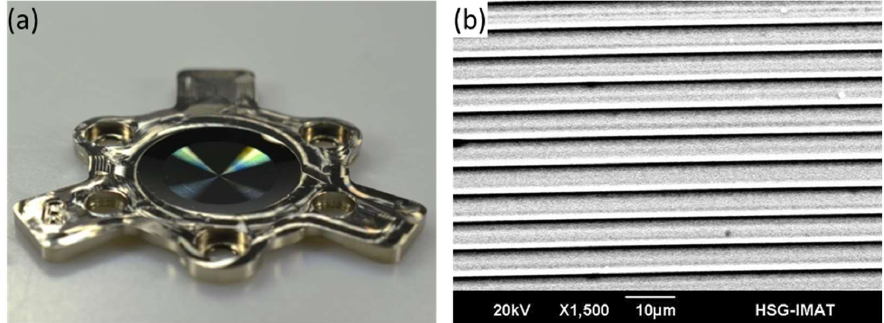
Figure 11. ( a ) Electroplated mold insert with diffractive structure, ( b ) SEM image of the diffractive structure.